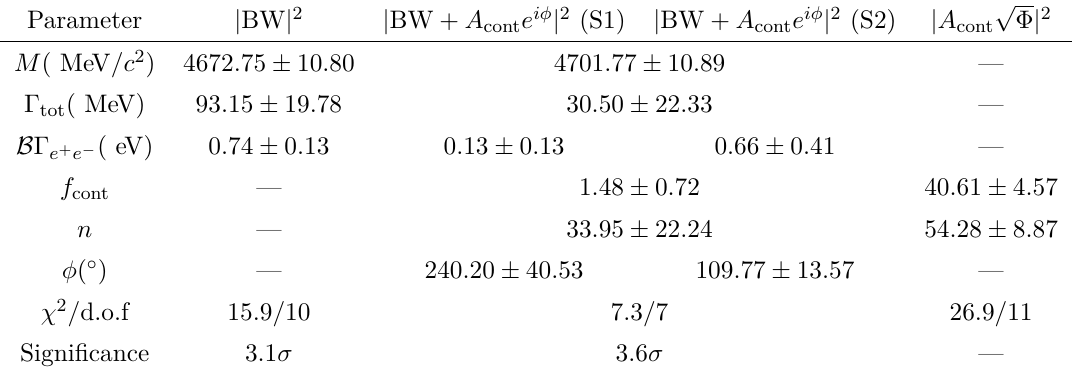
Table 4 . The numerical results for the fits to the cross section of e + e − → φχ c 2 with the single BW model (2nd column), the coherent sum of a BW and continuum model (3rd and 4th columns correspond to the constructive (S1) and destructive (S2) solutions of the interference), and PHSP corrected continuum model (5th column). The errors are